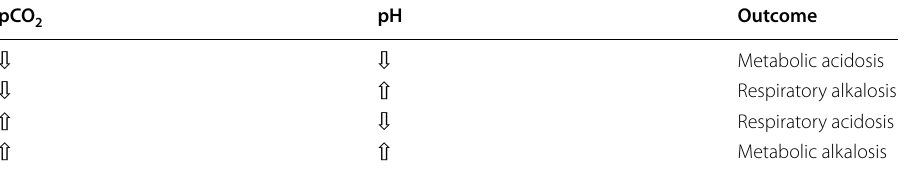
Table 1 Conditional flow sheet for determination of the most probable primary disturbance in initial level one of the